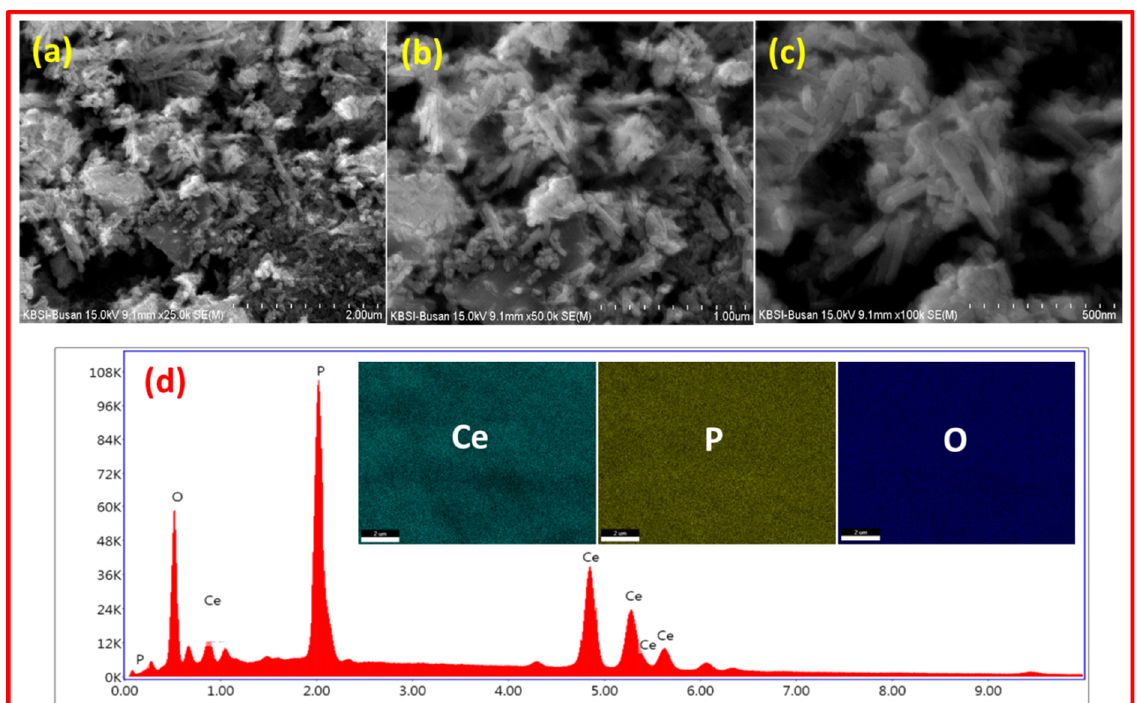
Figure 1. ( a – c ) SEM pictures of Ce(HPO 4 ) 2 .xH 2 O with various magnifications; ( d ) EDAX spectrum and inset of ( d ): elemental mapping of cerium, phosphorous, and